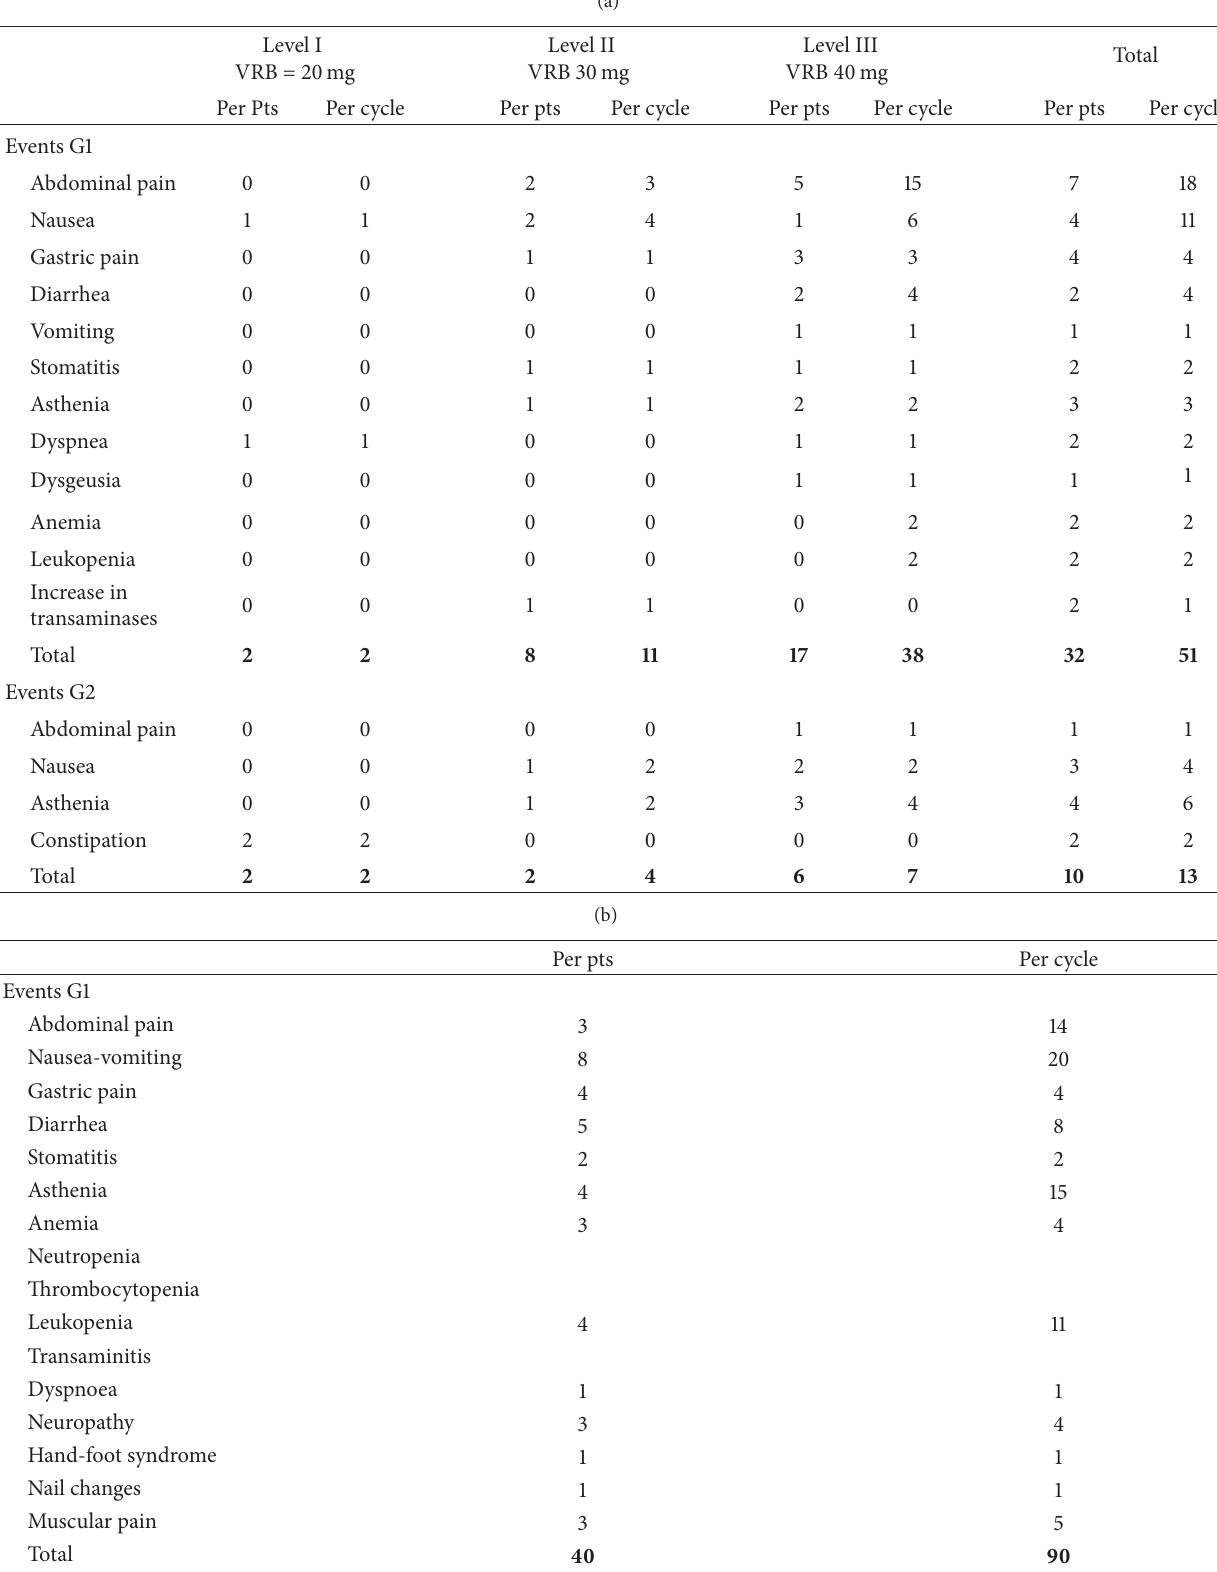
Table 2: Toxicity events according to grade and level of dose, described per patient and per cycle. (a) Phase I. (b) Phase II (VRB 40mg + CAPE 500 mg ×